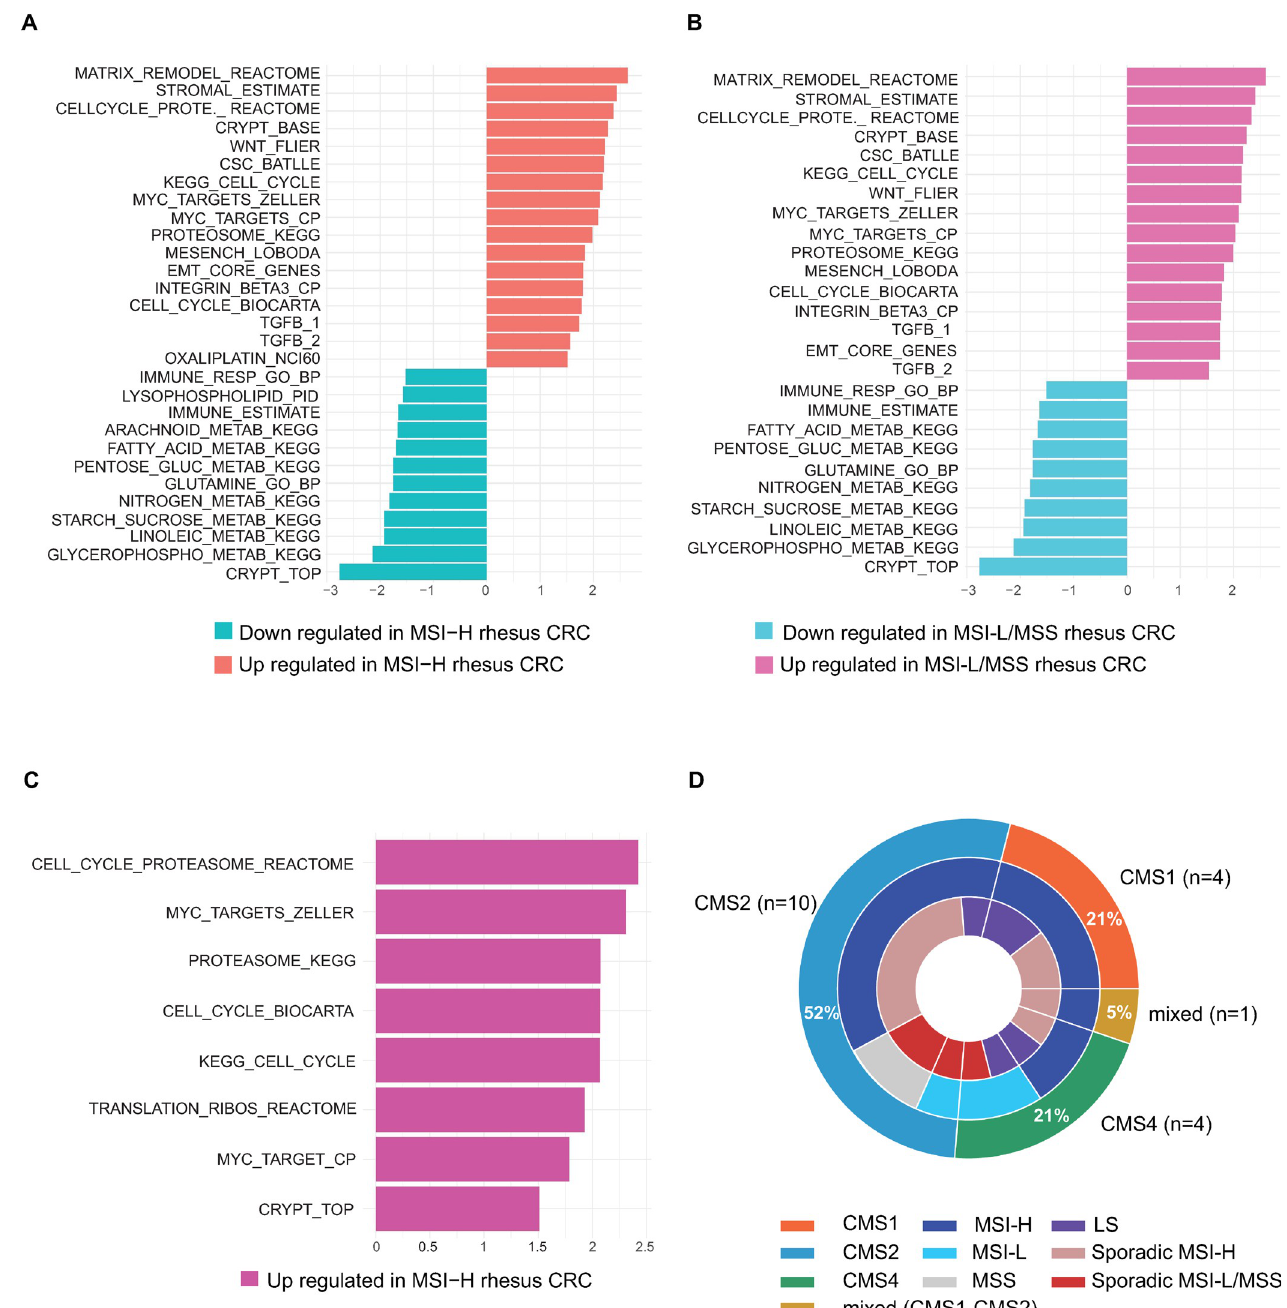
Fig 5. Gene set enrichment analysis in rhesus CRC. (A-C) Significant gene expression pathways relevant to CRC biology are highlighted in (A) MSI-H (sporadic and LS) and (B) in MSI-L/MSS (sporadic and LS) compared to normal tissue samples. (C) Highlighted pathways are up regulated in MSI-H (sporadic and LS) rhesus CRC compared to MSI-L/MSS (sporadic and LS) rhesus CRC. BH-adjusted P -value � 0.05 was set as threshold for analysis; (D) CMS classification of rhesus CRC. The outer ring of circos plot represents CMS subtypes present in rhesus CRC with 52% of samples (n = 10) classifying as CMS2. Middle ring represents MSI status of samples, and inner ring indicates clinical categories of